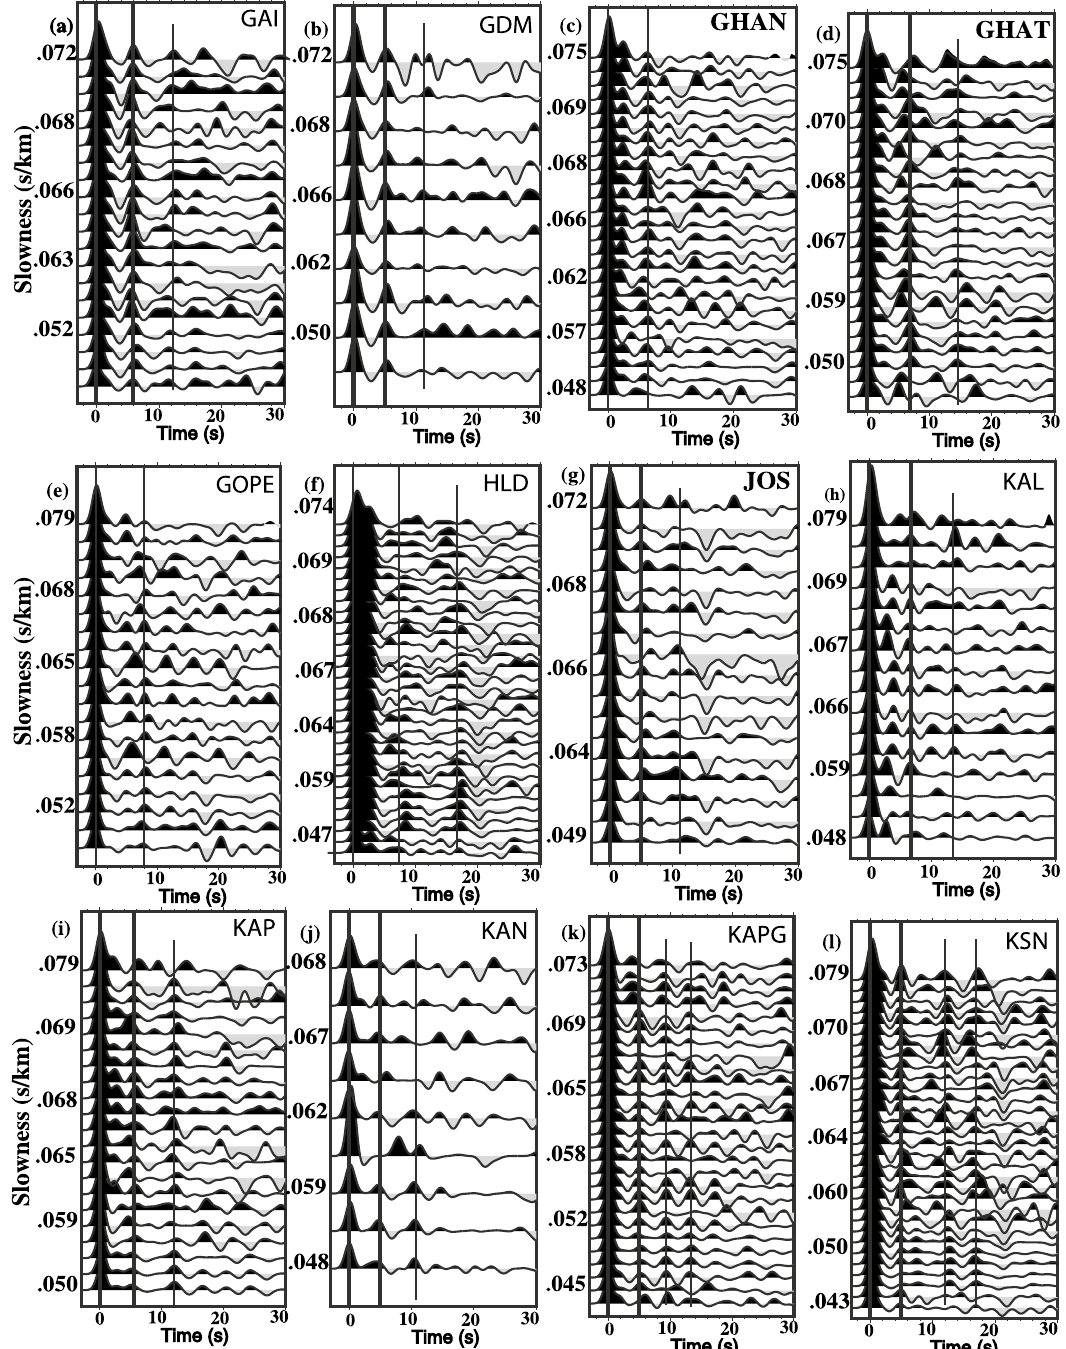
( a ) GAI, ( b ) GDM, ( c ) GHAN, ( d ) GHAT, ( e ) GOPE, ( f ) HLD, ( g ) JOS, ( h ) KAL, ( i ) KAP, ( j ) KAN, ( k ) KAPG, and ( l ) KSN. The PRFs at each station show strong azimuthal variation. The conversions from Moho and crustal multiples are marked by solid black